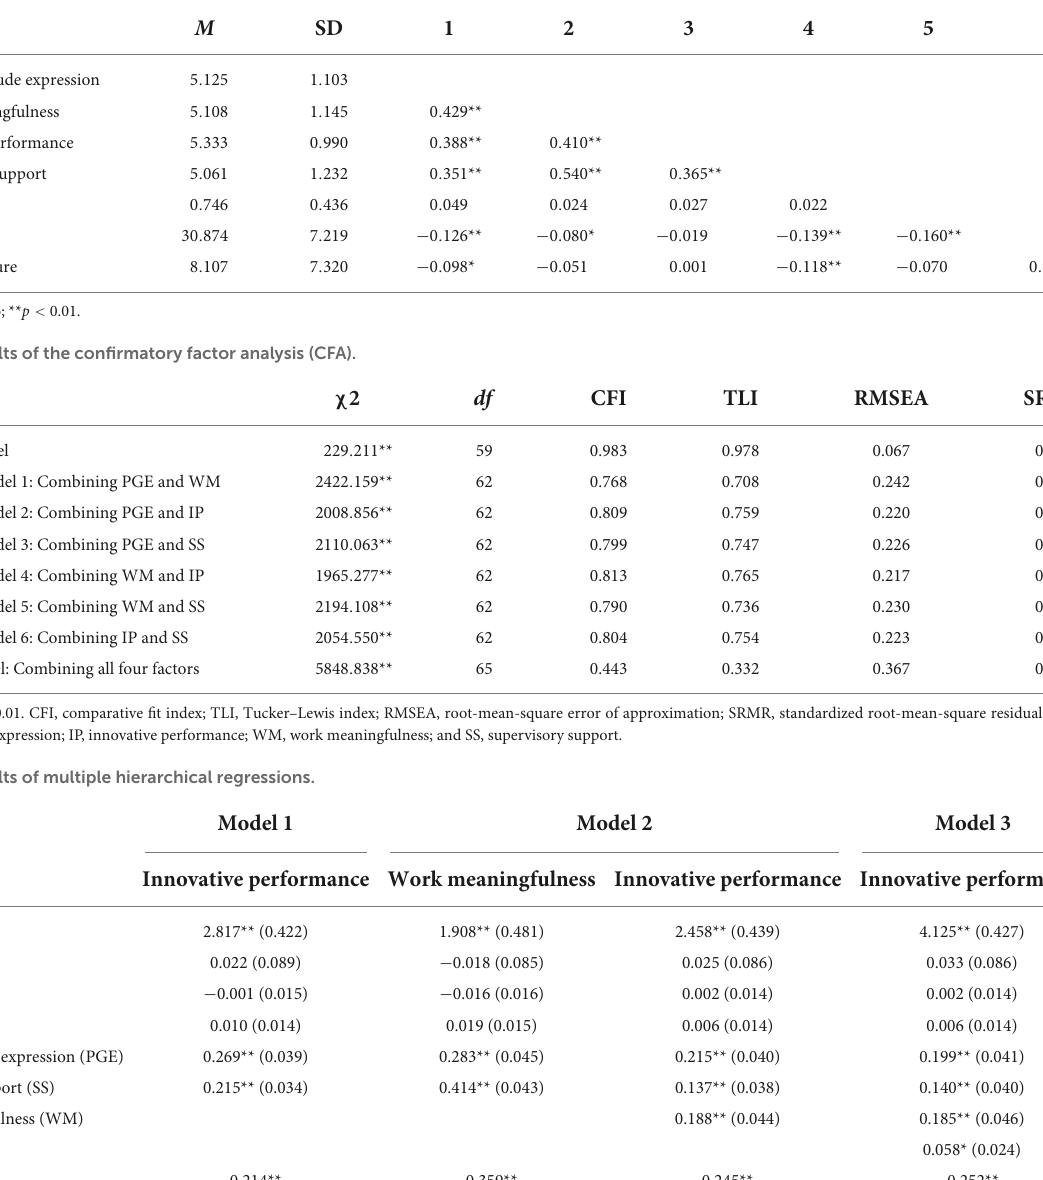
TABLE 1 Descriptive statistics and correlations.